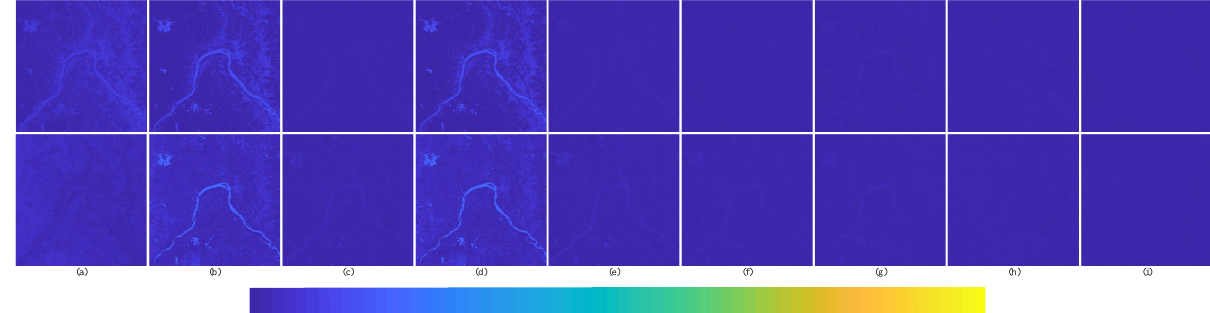
Figure 19. Average intensity difference maps and average spectral difference maps between pan-sharpened MS image and ground-truth MS image for testing dataset Landsat-7 with reduced resolution; the top row are the average intensity difference maps, the bottom row are the average spectral difference maps. ( a ) Brovey; ( b ) GS; ( c ) SFIM; ( d ) IFCNN; ( e ) PNN; ( f ) DRPNN; ( g ) PanNet; ( h ) ResTFNet; ( i ) RDFNet (ours).